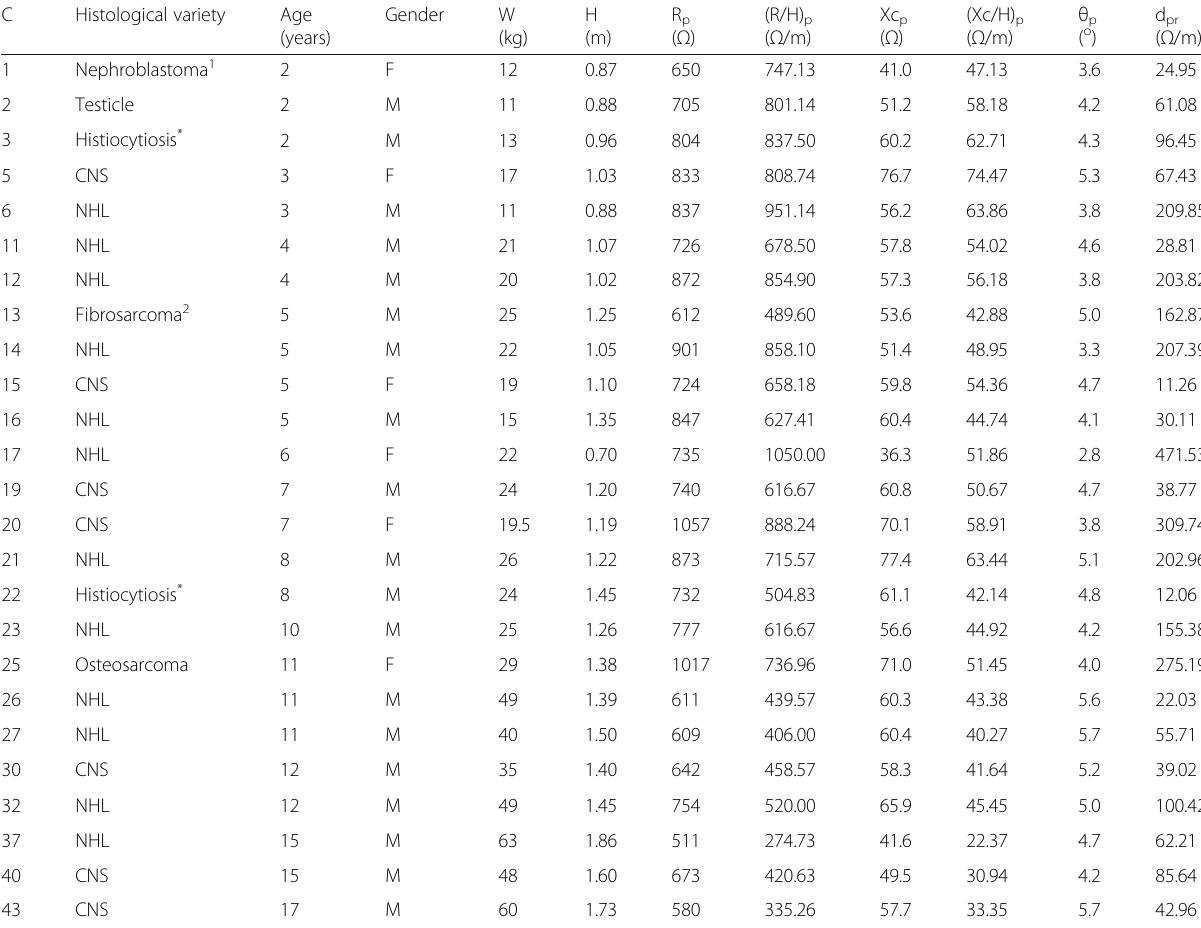
1 Right kidney. 2 Right gluteus. * Benign process with malignant behavior. Code (C), male gender (M), female gender (F), weight (W) and height (H) for each patient were specified. CNS symbolized Central Nervous System. NHL denoted Non-Hodgkin Lymphoma. R p , (R/H) p , Xc p , (Xc/H) p and θ p were the body electrical resistance, R p per unit of height, the body capacitive electrical reactance, Xc p per unit of height and the body phase angle of each patient, respectively. d pr represented the distance between the points ((R/H) r , (Xc/H) r ) and ((R/H) p , (Xc/H) p ), for each gender and age group. The subscript p was referred to the solid tumor child while the subscript r to the population of apparently healthy children. Values of (R/H) r and (Xc/H) r were shown in Table 1 and reported in [16] (courtesy of MSc. Alcibiade Lara Lafargue and Centro Nacional de Electromagnetismo